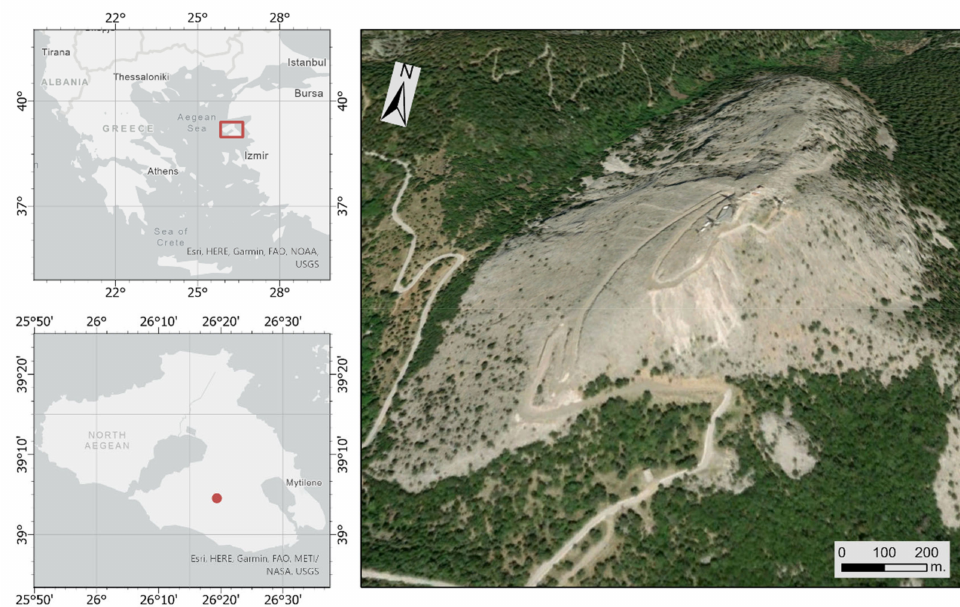
Figure 2. Location of the study area, Olympus Tectonic Window, Lesvos, Greece (Sources: Esri, Digital- Globe, Coordinate system: World Geodetic System